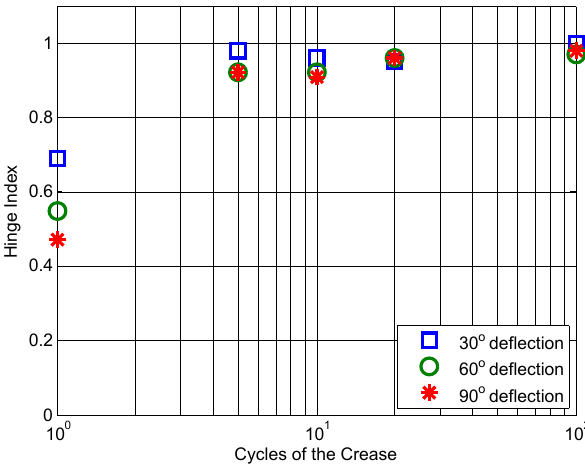
Figure 10. Polypropylene (0.25 mm thick): hinge index verses cy- cles of the crease.